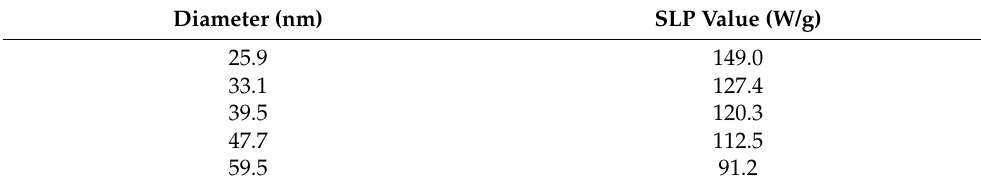
Table 3. SLP values of various Fe 3 O 4 @Au NP